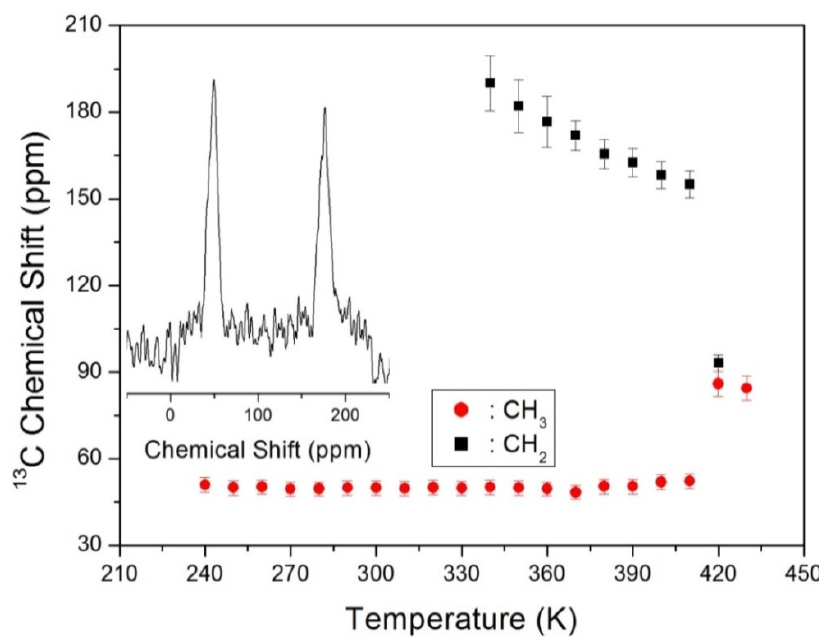
Figure 6. 13 C chemical shift in CH 3 and CH 2 groups in (C 2 H 5 NH 3 ) 2 CoCl 4 as a function of temperature (inset: 13 C MAS NMR spectrum at 360 K).